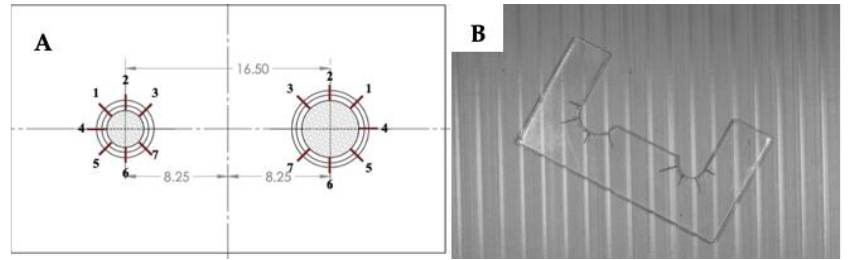
Figure 3. ( A ) Illustration of seven reference points on abutment model. ( B ) Photographs of a customized acrylic template.